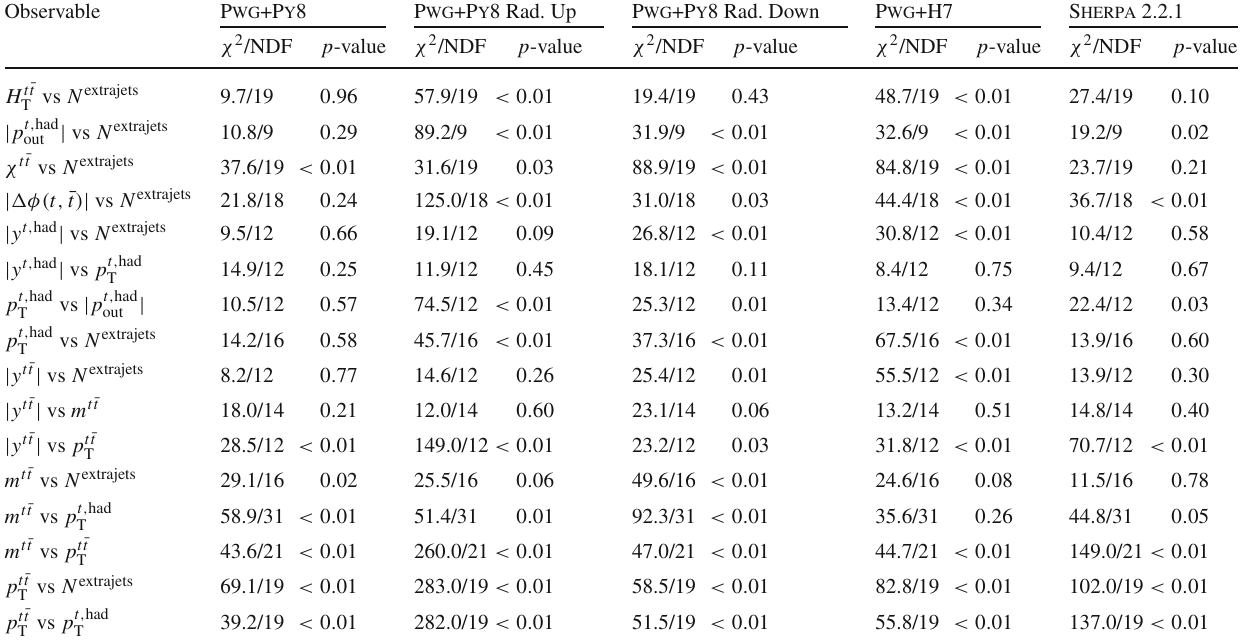
Table 11 Comparison of the measured particle-level normalised double-differential cross-sections in the resolved topology with the pre- dictions from several MC generators. For each prediction a χ 2 and a